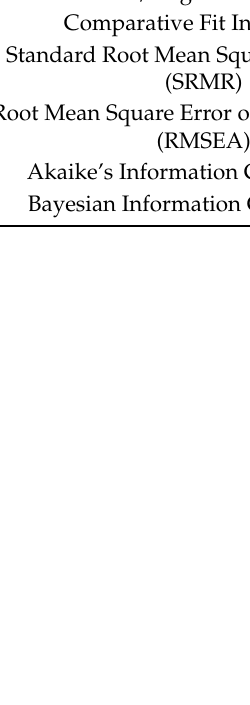
Table 4. Factor Loadings, AVE, HTMT and Reliability